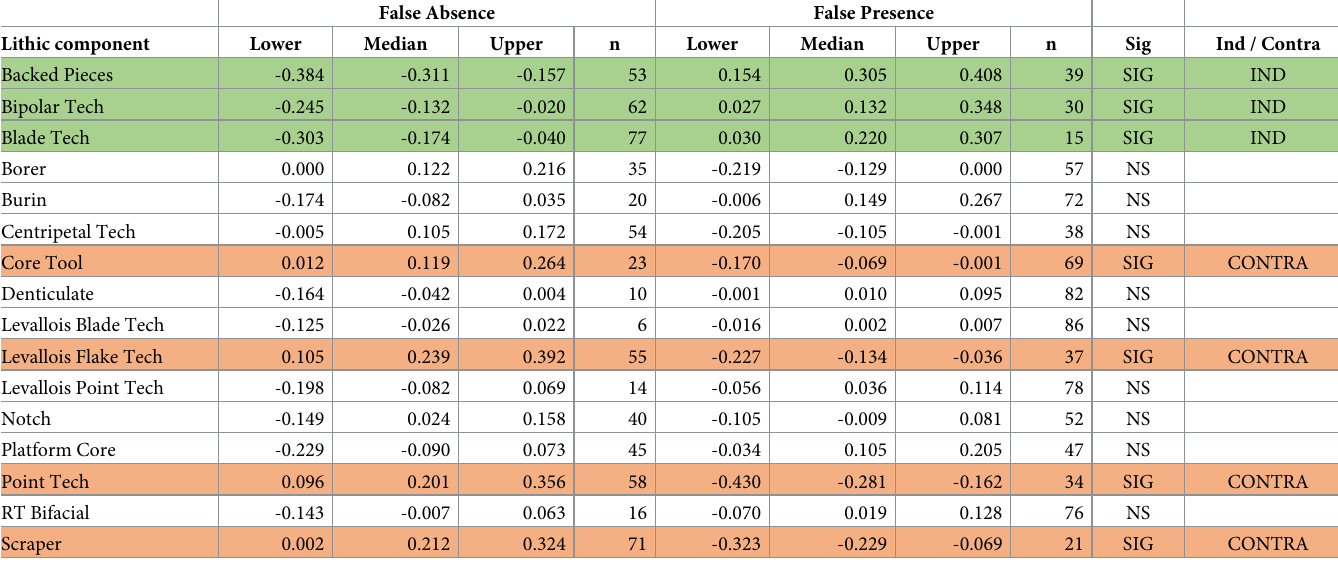
Table 8. Significant indicators of LSA and MSA assemblages in the 2-way